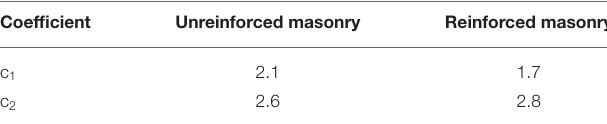
TABLE 7 | Terms of Equation